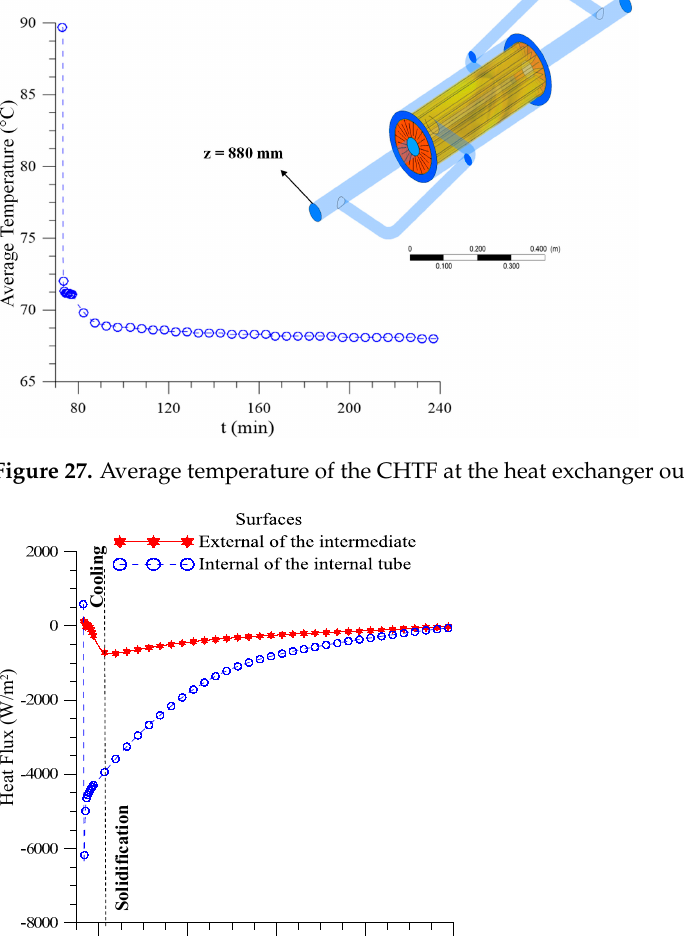
Energies 2023 , 16 , x FOR PEER REVIEW 30 of 35